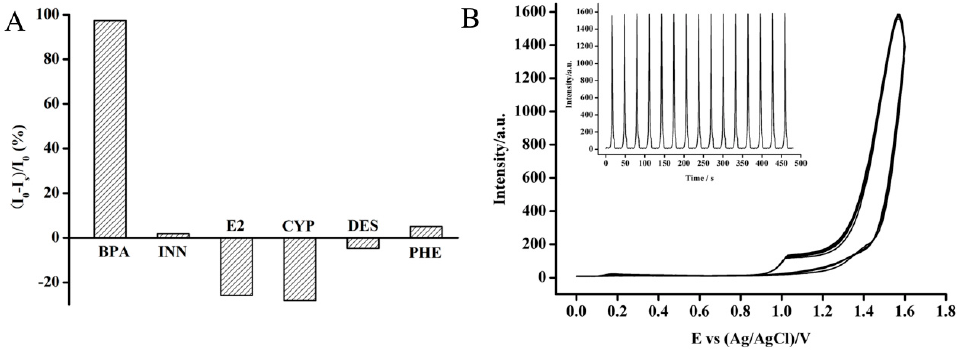
Figure 7. Selectivity ( A ) and stability ( B ) of the developed ECL sensor for BPA detection. Scan rate: 100 mV/s.